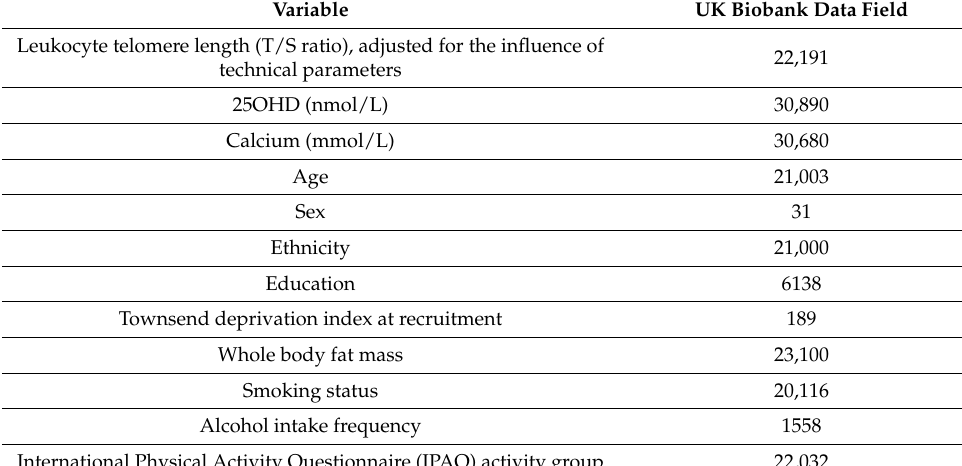
Table 1. Data used to examine the association between leukocyte telomere length(LTL) and serum 25OHD. https://biobank.ndph.ox.ac.uk/showcase/search.cgi (accessed on 16 March 2023). Variable